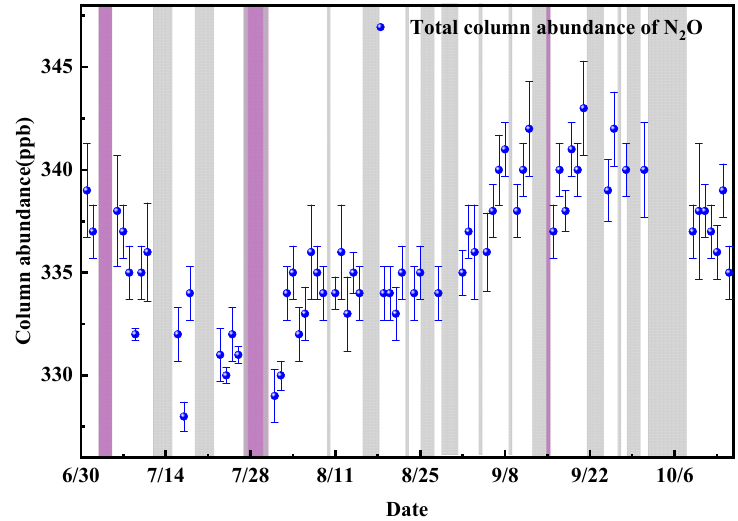
Figure 7. Time series of the N 2 O retrieval results. Estimations of 95% confidence ranges are indi-